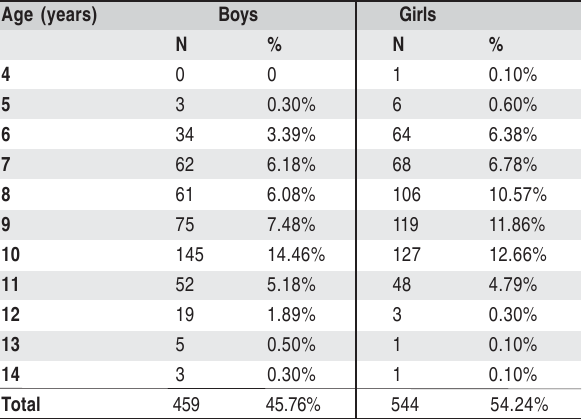
Table 1 - Age distribution of